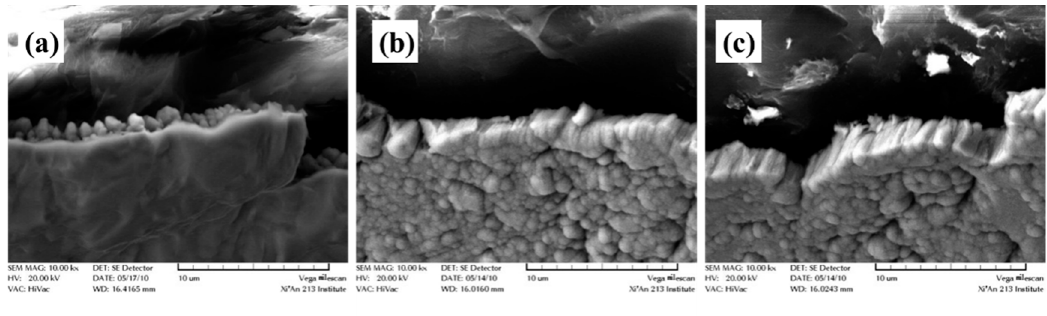
Figure 5. SEM images of copper film. ( a ) Sample A, ( b ) Sample B, and ( c ) Sample C.